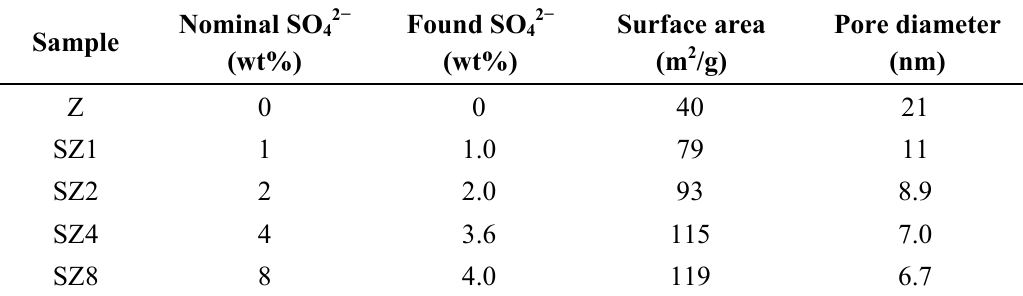
Table 1. Textural properties of the